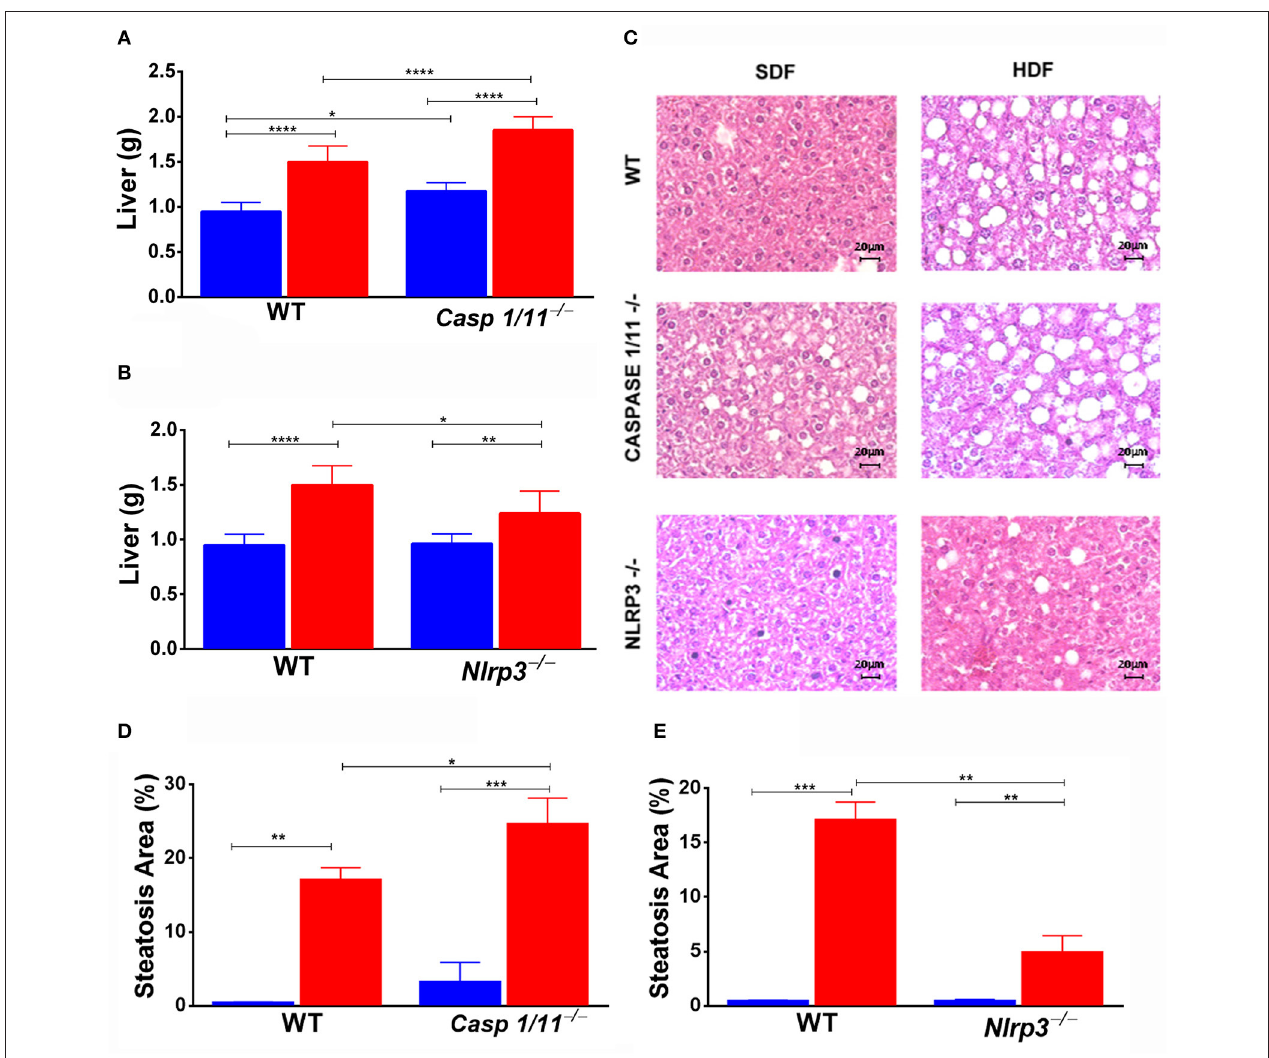
FIGURE 2 | Weight of organs and hepatic steatosis development. WT, caspase-1/1 − / − and Nlpr3 − / − mice were fed SFD (17% fat) or HFD (45% fat) for 90 days; after treatment, the liver was collected. Weight of liver (A,B) and hematoxylin and eosin staining of the liver (C) after treatment. Hepatic steatosis scores (D,E) were determined with semi-quantitative pathological standards. ANOVA test was applied, the bars representing confidence interval of 95% (* p < 0.05, ** p < 0.01, *** p < 0.005, and **** p <